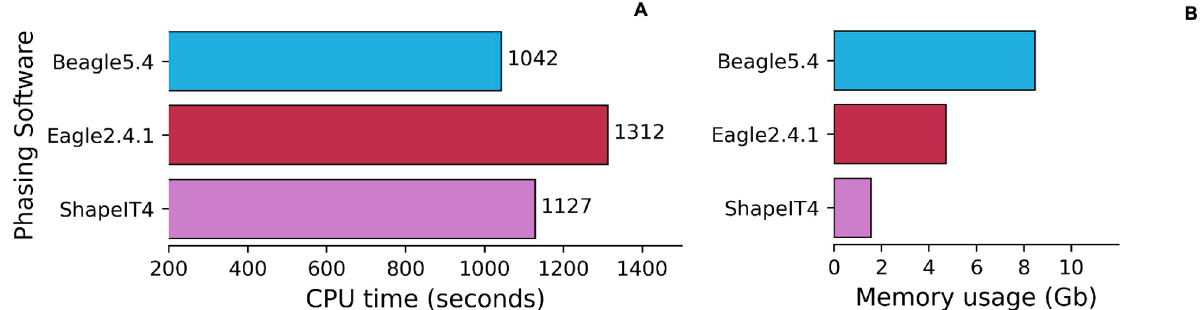
Fig 7. CPU run time and memory usage for phasing softwares in EBB chip dataset. Average run time for phasing (6A). Average memory usage for phasing (6B) in chips data.